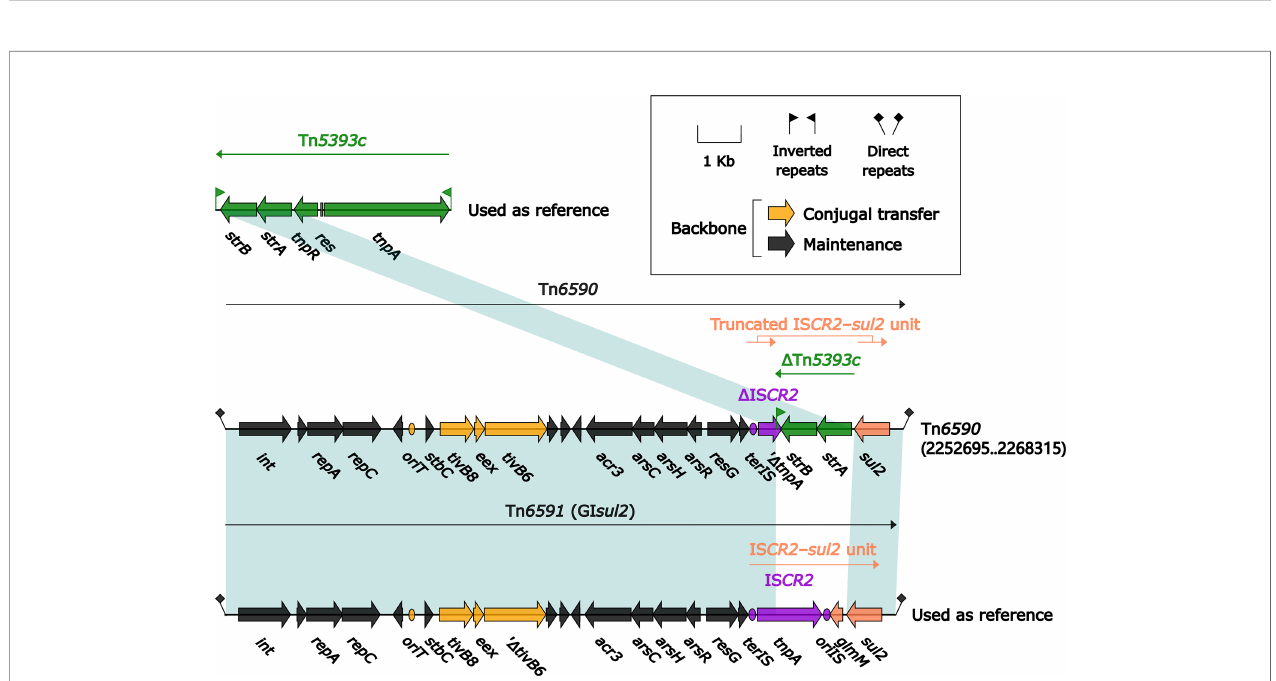
FIGURE 11 | Organization of two related IMEs Tn 6590 and Tn 6591 , and comparison to related regions. Genes are denoted by arrows. Genes, mobile elements, and other features are colored based on their functional classi fi cation. Shading denotes regions of homology (nucleotide identity ≥ 95%). Numbers in brackets indicate nucleotide positions within the chromosome of strain 51003. The accession number of Tn 5393c (L ’ Abe ́ e-Lund and Sørum, 2000) used as reference is AF262622.